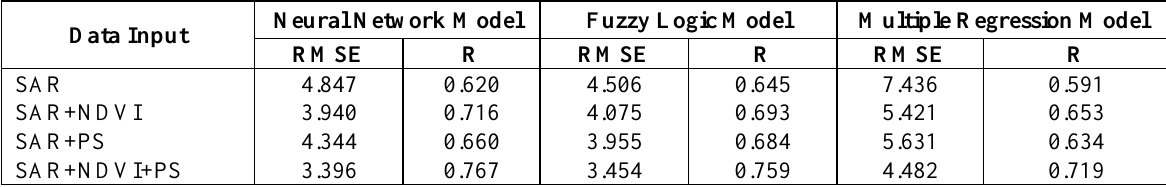
Table 4. Effect of data input configuration used in neural network, fuzzy logic and multiple regression model in terms of Root means square error (RMSE) and correlation coefficient (R) values of predicted soil moisture and ESTAR soil moisture for independent 300 pixels from Area A on 12 th July